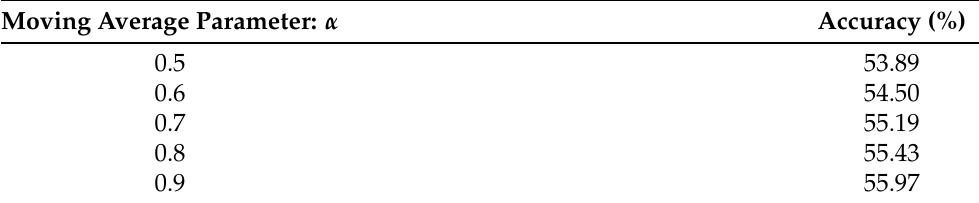
Table 2. Experiment of Bidirectional exponential moving average parameter α .